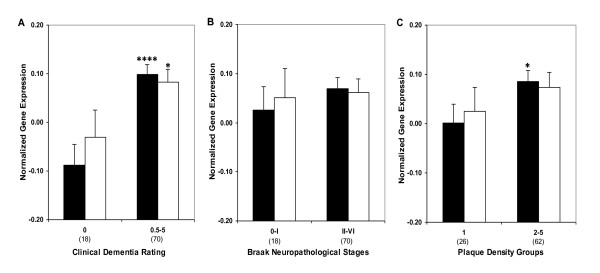
RXRα (Black bars) and LXRβ mRNA (white bars) expression in individuals with and without dementia or AD-associated neuropathology in area 20. Mean values ± SEM are shown. *, p < 0.05; ****, p < 0.0001. Number within the parentheses indicates the individuals within each group.